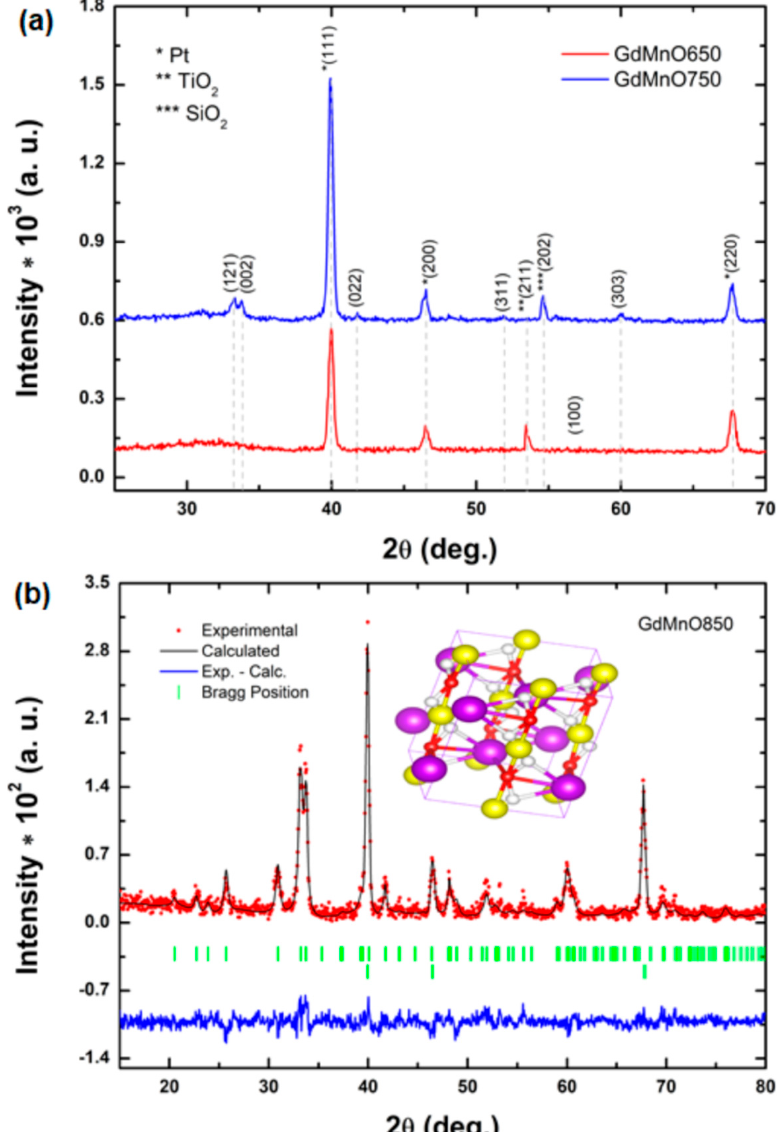
Figure 1. ( a ) X-ray diffraction (XRD) patterns of GdMnO 3 thin films sintered at 650 and 750 °C. ( b ) Structural Rietveld refinement of GdMnO 3 thin film sintered at 850 °C. Table 1. Structural parameters of GdMnO850 thin film obtained by structural Rietveld refinement. Sample